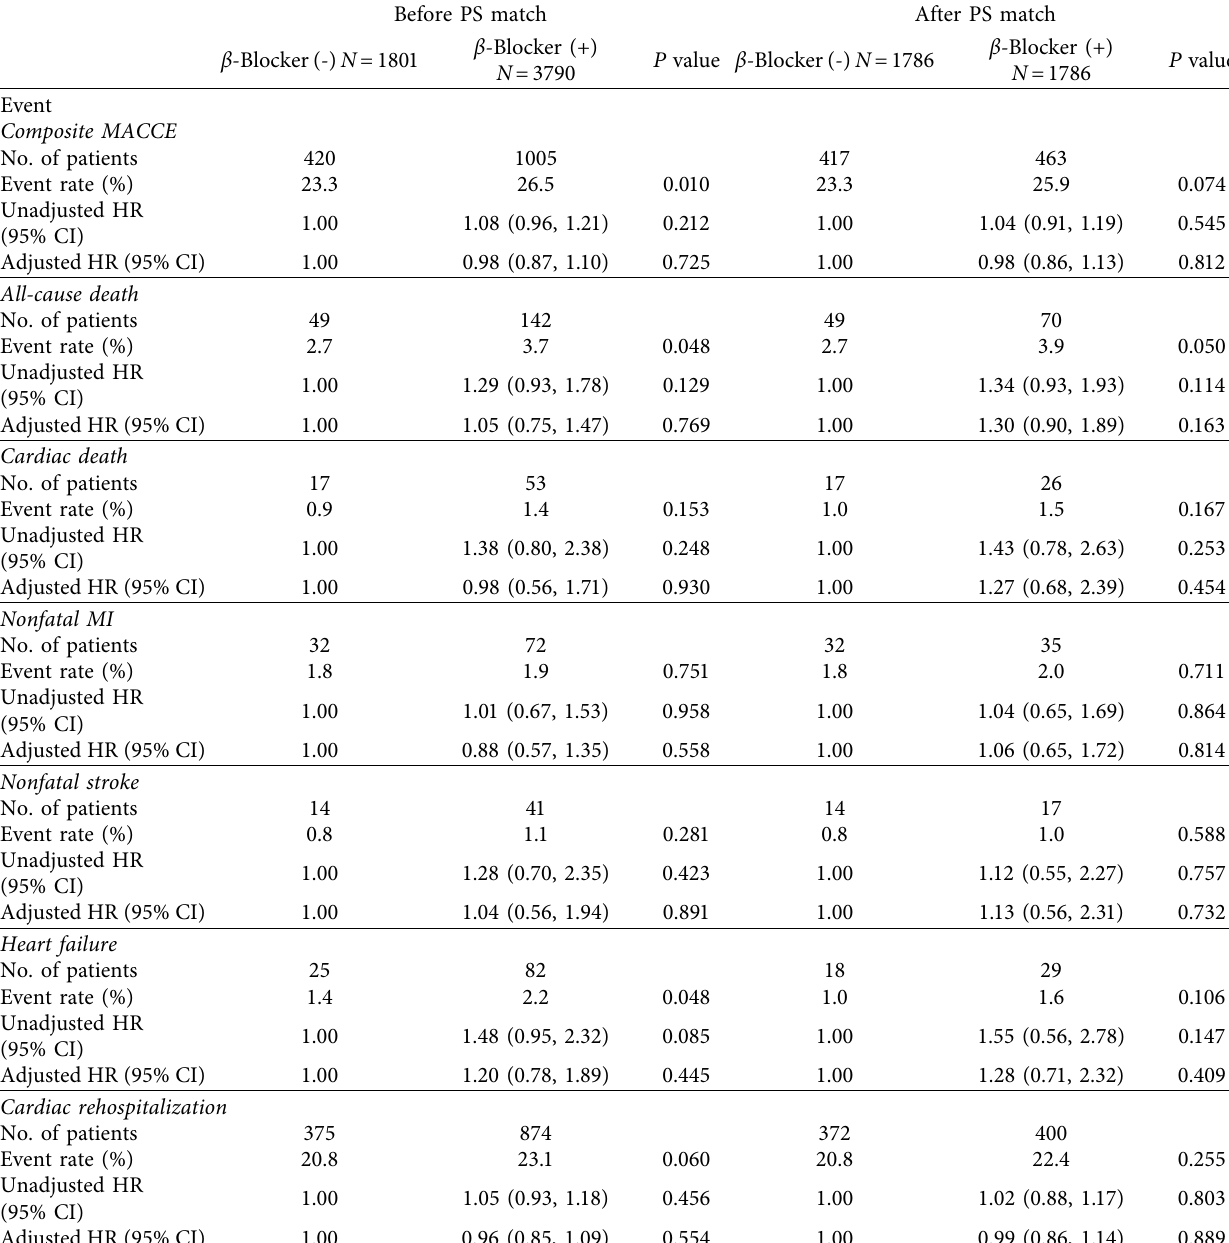
Table 3: Major adverse cardiac and cerebral events in patients with UAP in the β -blocker and no β -blocker groups. Before PS match After PS